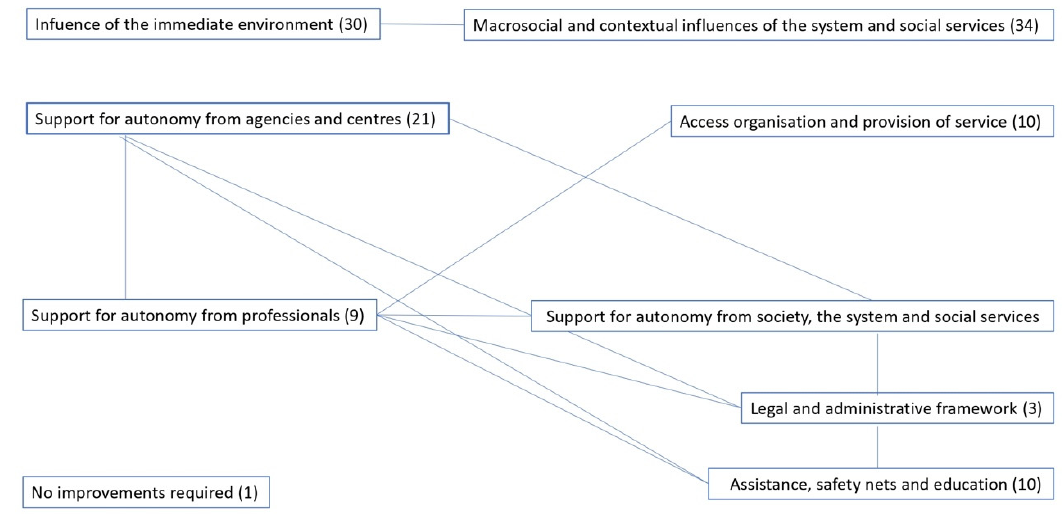
Figure 1. Relational model between codes and subcodes: suggestions for the management and use of time with young people during their transition to adulthood regarding levels of macrosocial influence, the system and social services, as well as the immediate environment. Source: authors’ own work.